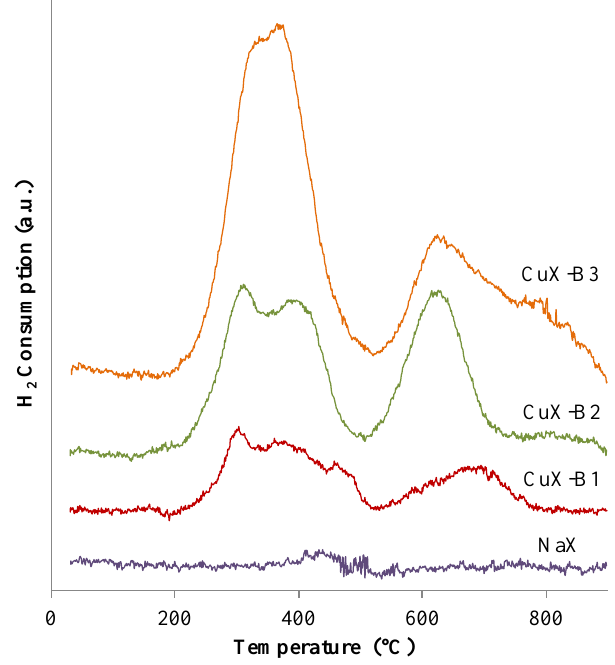
Figure 1. H 2 -TPR profiles of the NaX and copper-exchanged